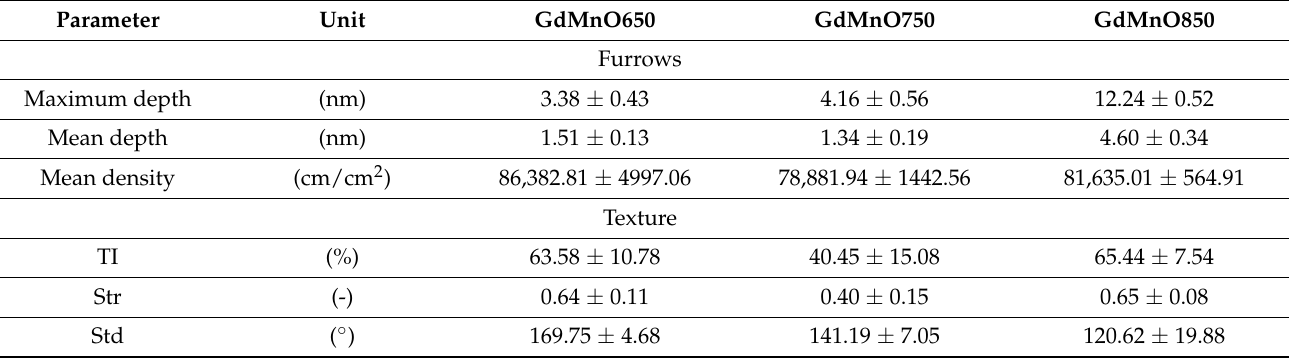
Table 4. Surface microtexture parameters of GdMnO 3 thin films according to ISO